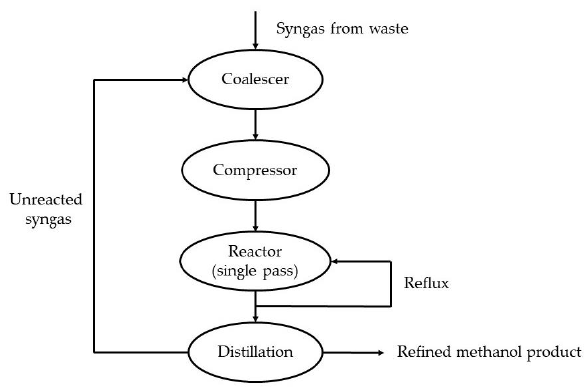
Figure 1. Process of synthesizing methanol [9].